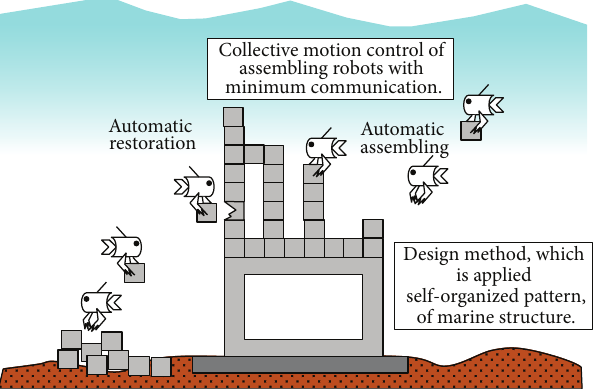
Figure 1: Outline of a self-organizing marine structure. The unified modules (structural units) are piled on a basement at the bottom of the sea and eventually the structure with the appropriate shape emerges. It is assumed that each module only communicates with adjacent units. Using the attribute of emerging pattern in one- dimensional cellular automata, specific structures based on the local interaction of transition rules without using complex algorithms can be